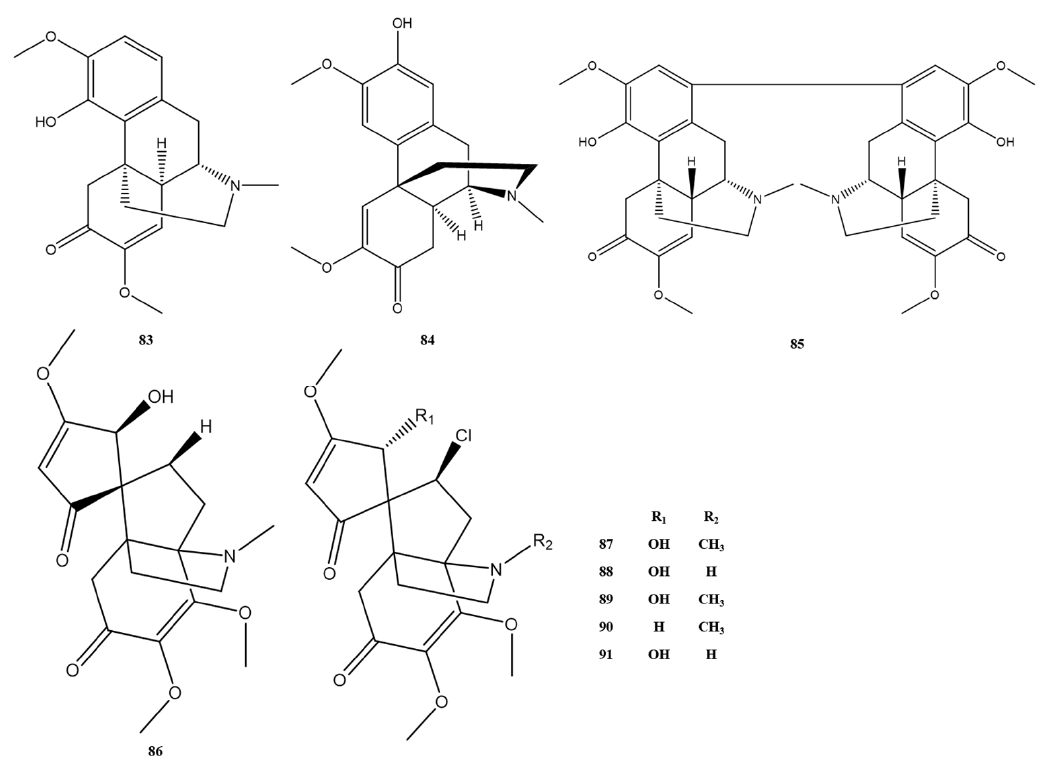
Figure 7. Morphine alkaloids in M. Rhizoma.